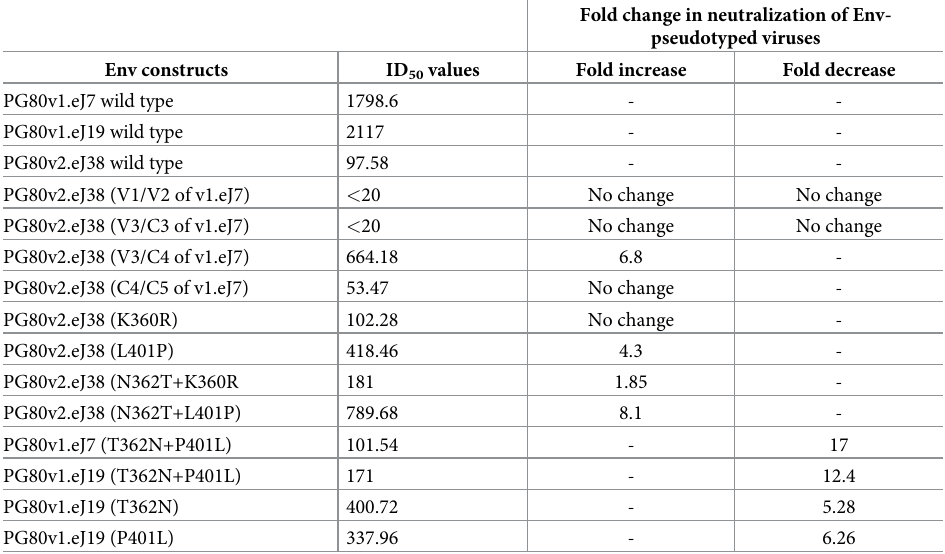
Table 3. Mapping fine specificity of rabbit serum antibodies associated with neutralization of autologous